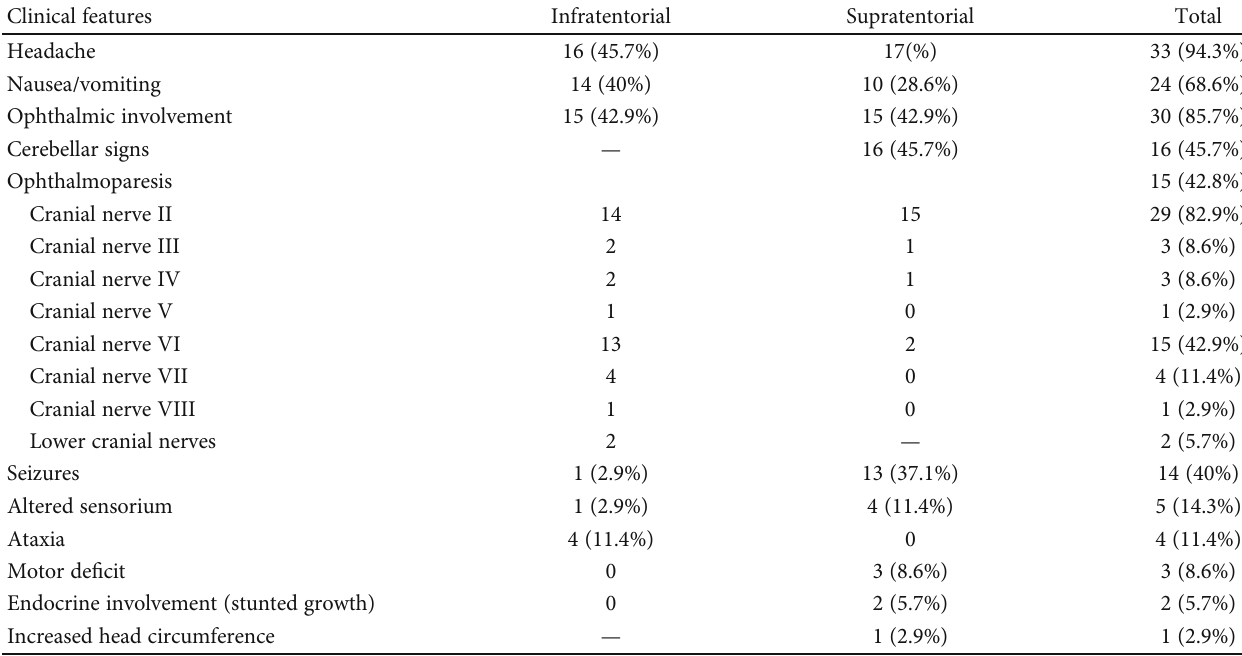
Table 1: Frequency of neurological signs and symptoms according to supratentorial and infratentorial location of the tumour. Clinical features